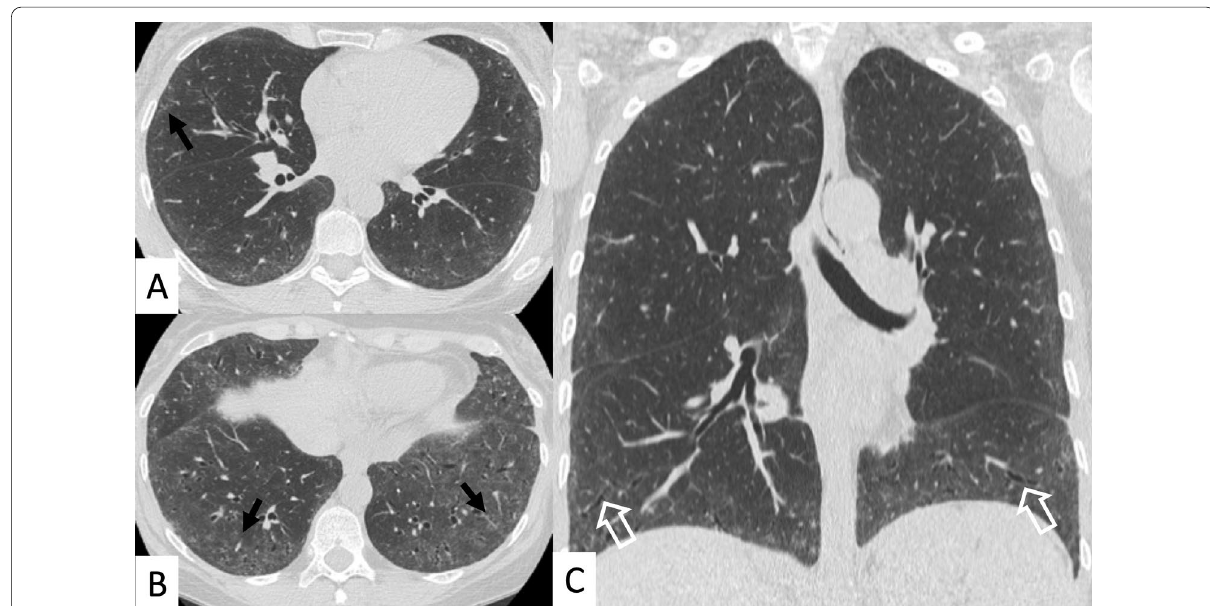
Fig. 11 Axial ( A , B ) and coronal ( C ) HRCT images of an SSc patient demonstrate NSIP pattern with ground-glass opacities (black arrows), well depicted in the subpleural and basal regions of the lung; fine reticulations may be also observed. Coronal MPR image is useful to better delineate the presence of small bronchiectasis, which may be seen in the peripheral basal regions (white empty arrows)